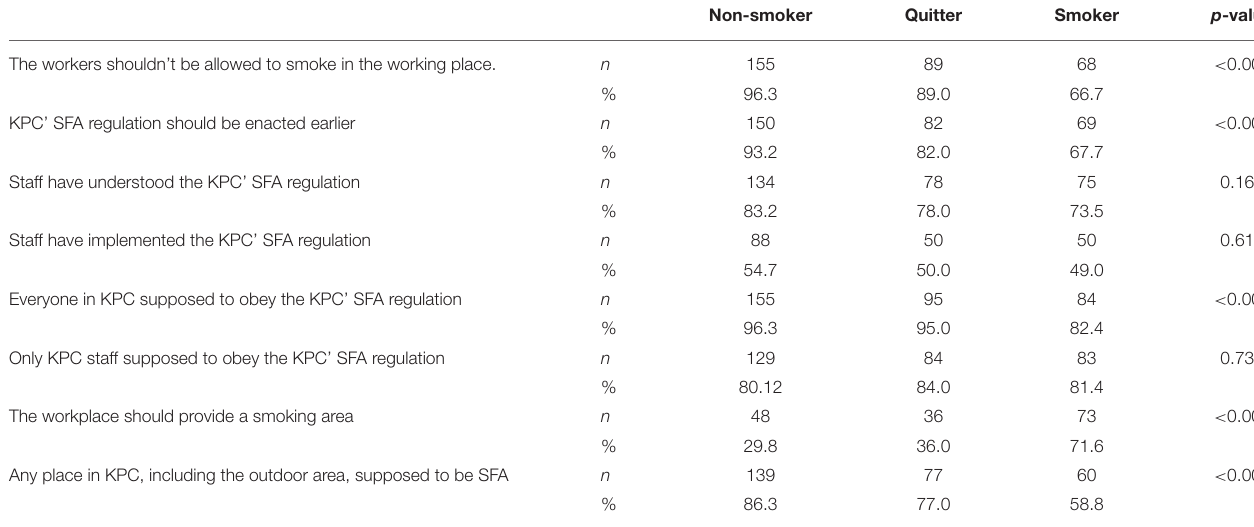
Non-smoker Quitter Smoker p -value